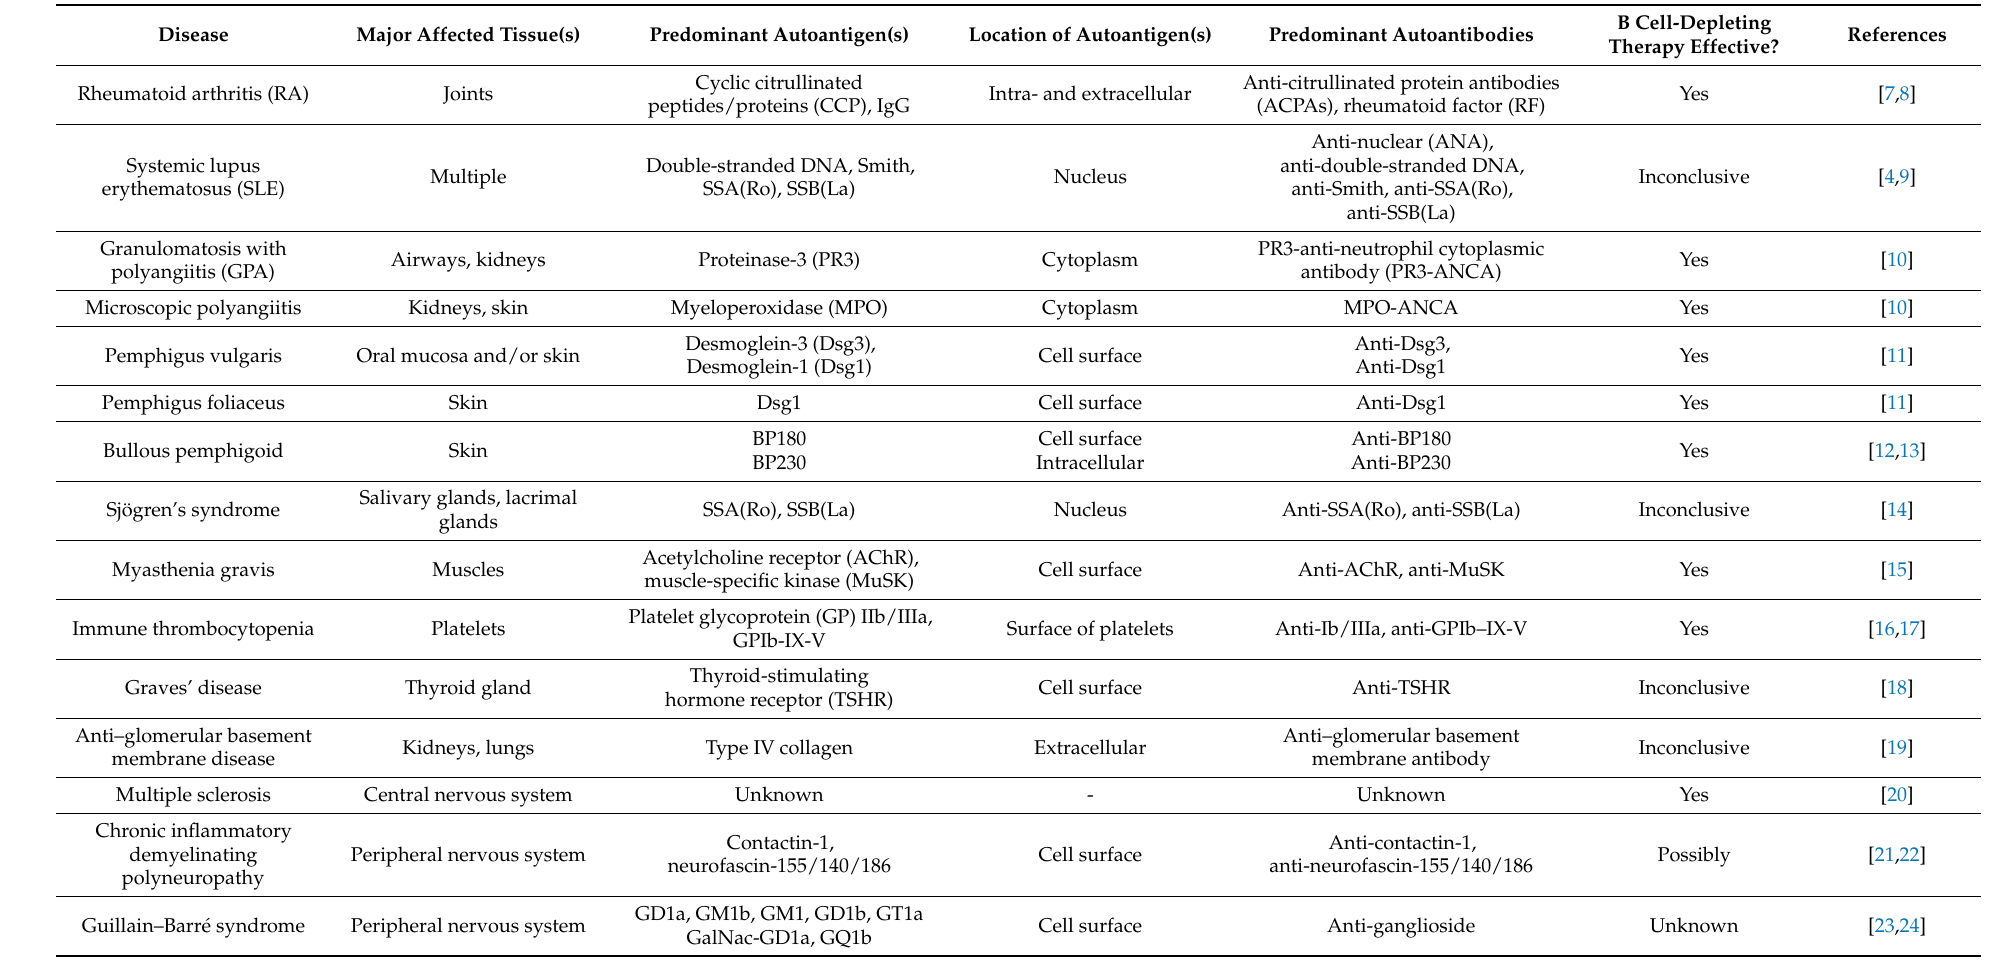
Table 1. Summary of various classical B cell-mediated autoimmune